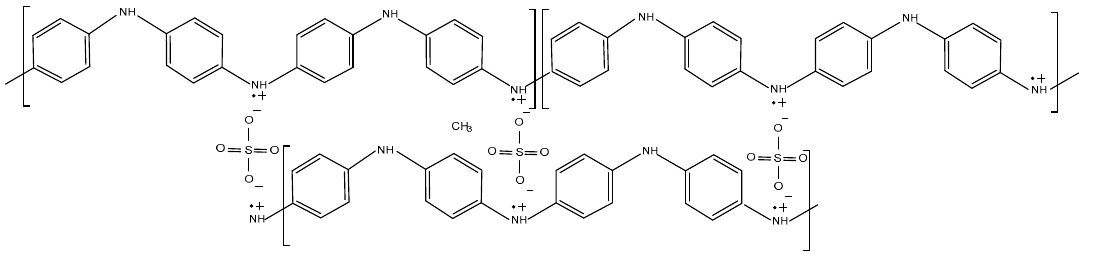
Figure 2. Schematic presentation of emeraldine state of PANI doped by sulfate ions.